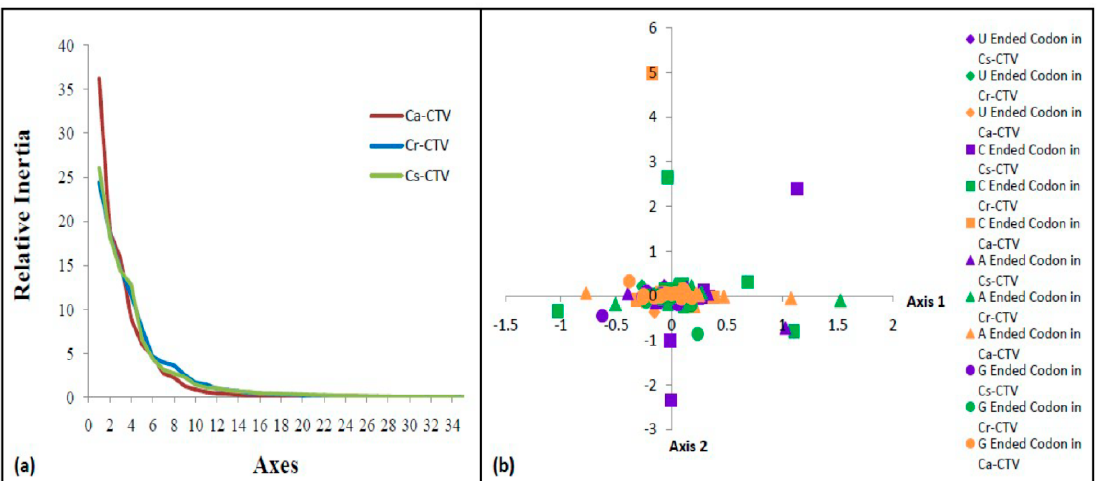
Table 3. The relative synonymous codon usage (RSCU) patterns of CTV isolates and their respective citrus hosts.